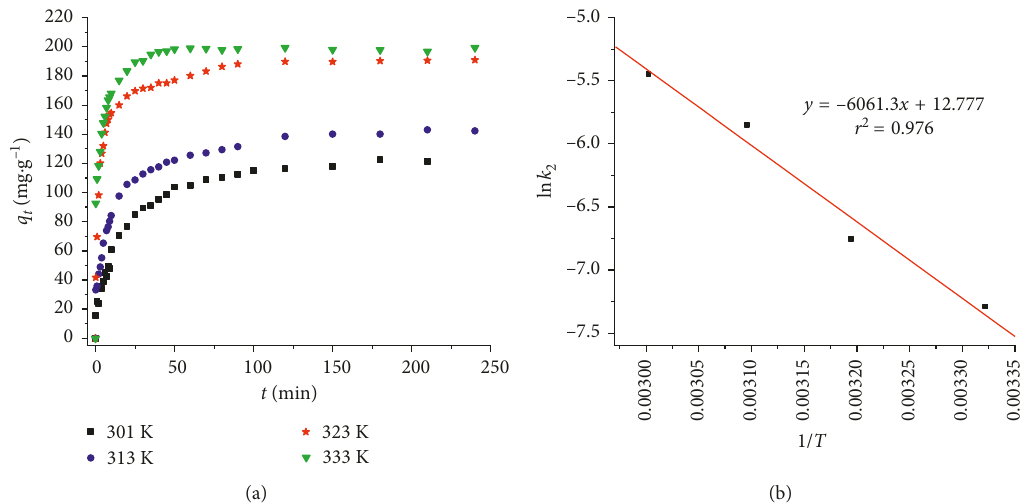
Figure 7: (a) RDB adsorption kinetics on MIL-101 at different temperatures; (b) Arrhenius